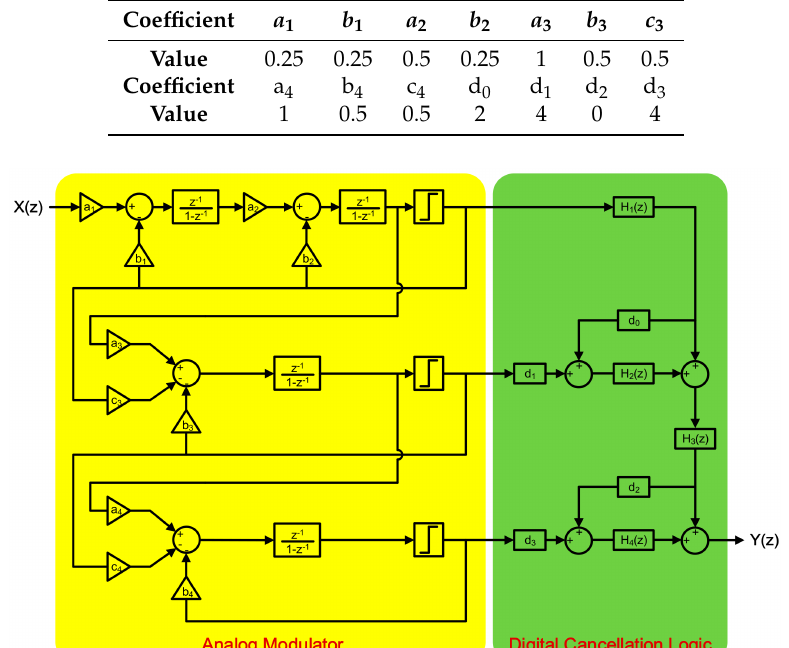
Figure 2. Proposed MASH 2-1-1 Σ∆ modulator